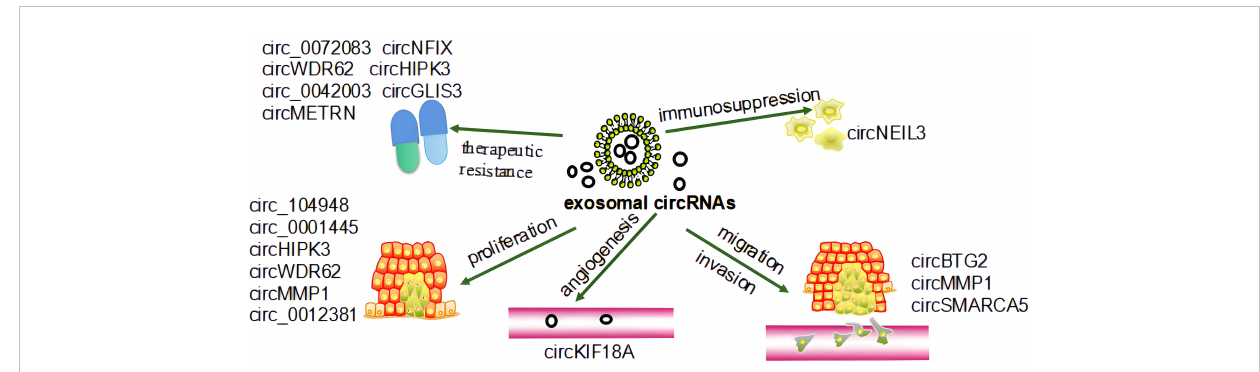
FIGURE 2 The role of exosomal circRNAs in the development of glioma. Exosomal circRNAs affect the progression of glioma by regulating its proliferation, invasion, migration, angiogenesis, and therapeutic resistance (30, 96 –